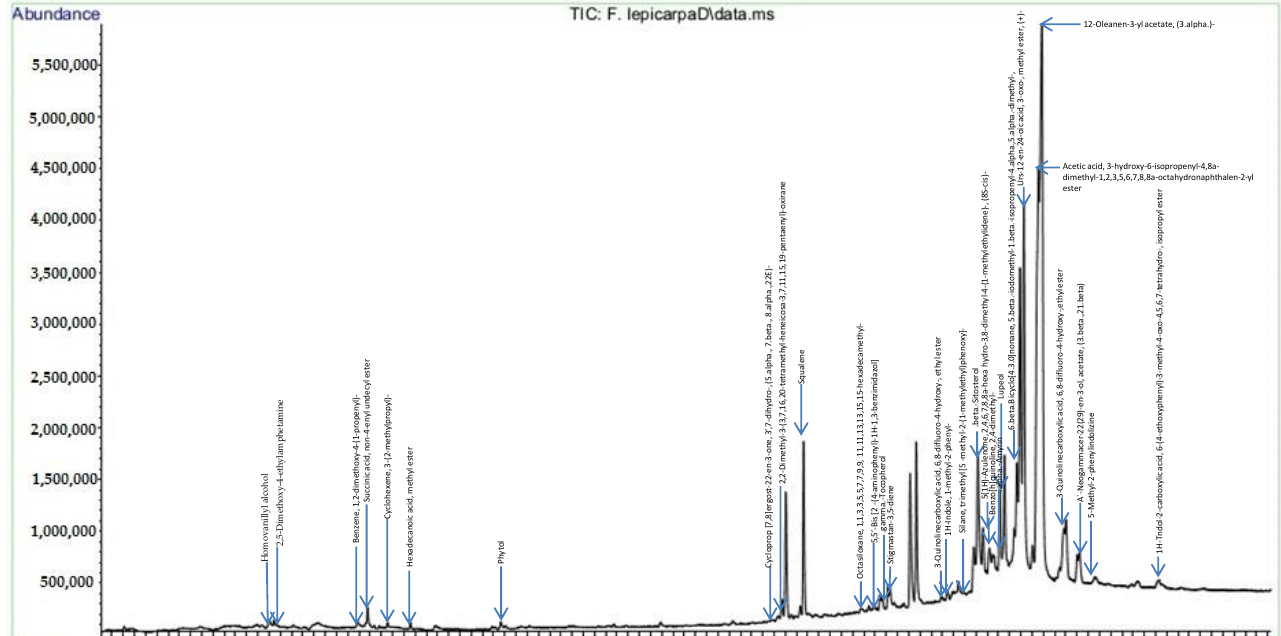
Figure 1. In Table 2, the presence of 30 different bioactive compounds was tabulated along with retention time (Ret. Tim) and area percentage (%). The identified major compounds are 12-Oleanen-3-yl acetate, (3.alpha.)—(21.09%), urs-12-en-24-oic acid, 3-oxo-, methyl ester, (+)- (9.80%) and acetic acid, and 3-hydroxy-6-isopropenyl-4,8a-dimethyl-1,2,3,5,6,7,8,8a- octahydronaphthalen-2-yl ester (13.69%).